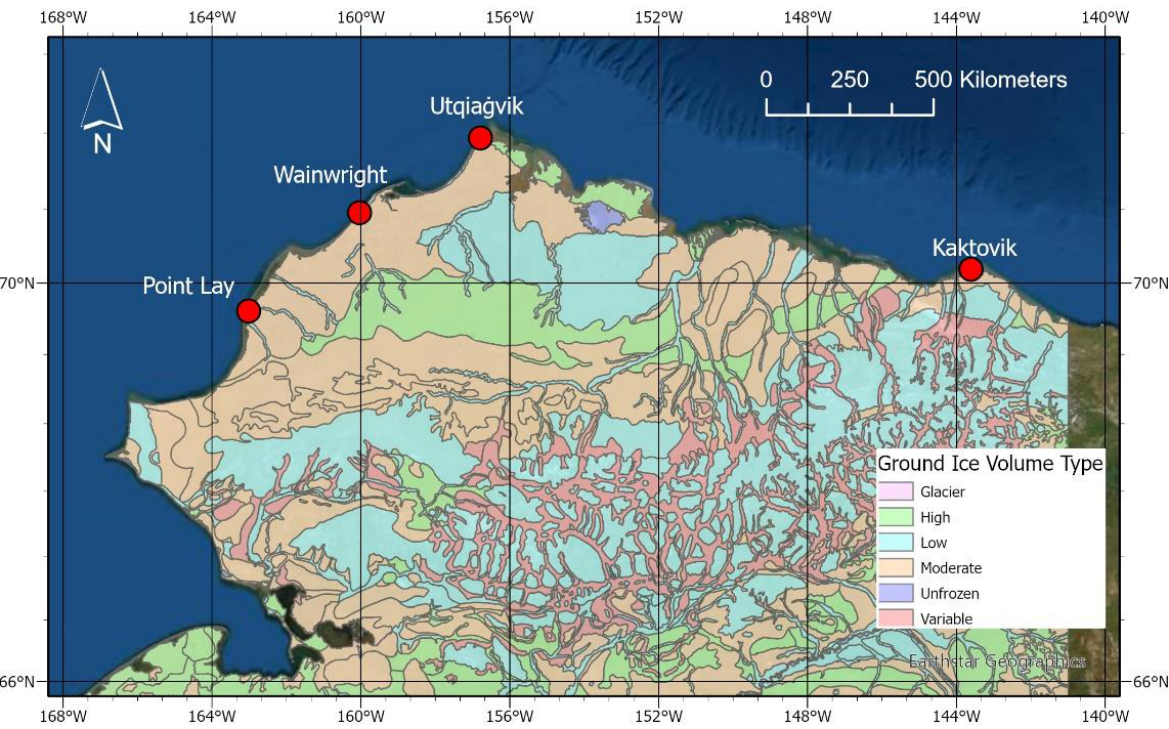
Figure 2. Ground-ice distribution in northern Alaska. The map is adapted from the original developed by Jorgenson et al. [30]. The four collaborating communities are indicated with red markers. The four villages are experiencing coastal erosion according to USACE in 2009 [31].